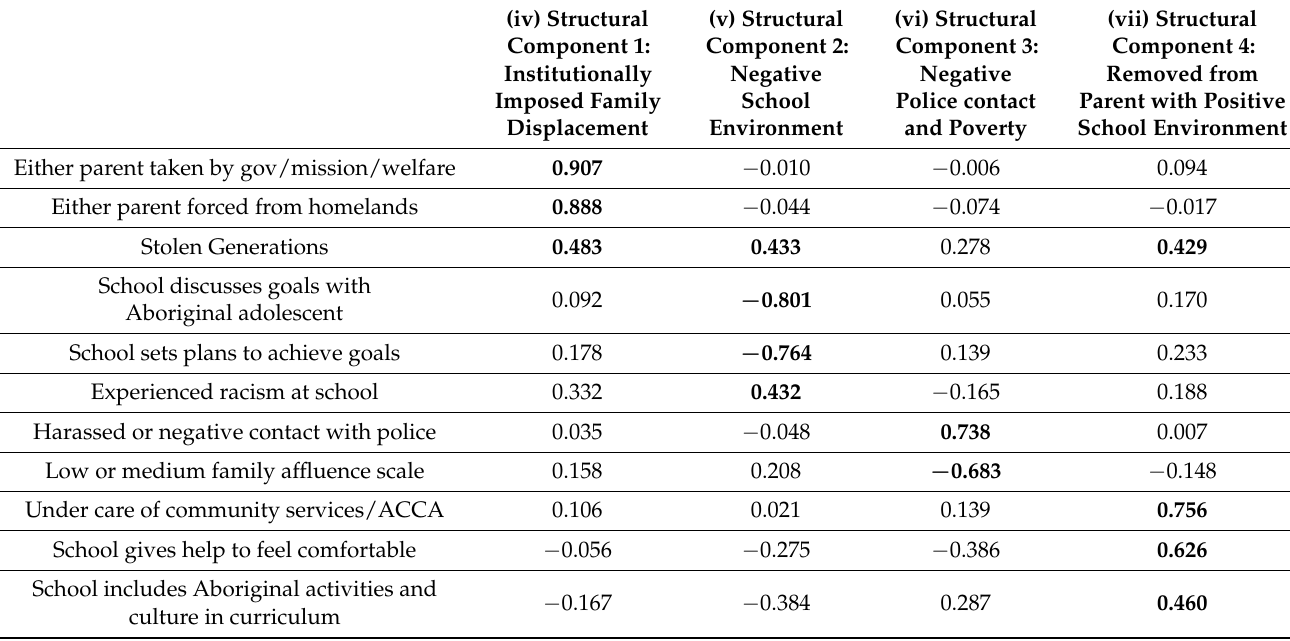
Table 4. Principal component analysis of structural determinants ( n = 68; includes all participants with a complete